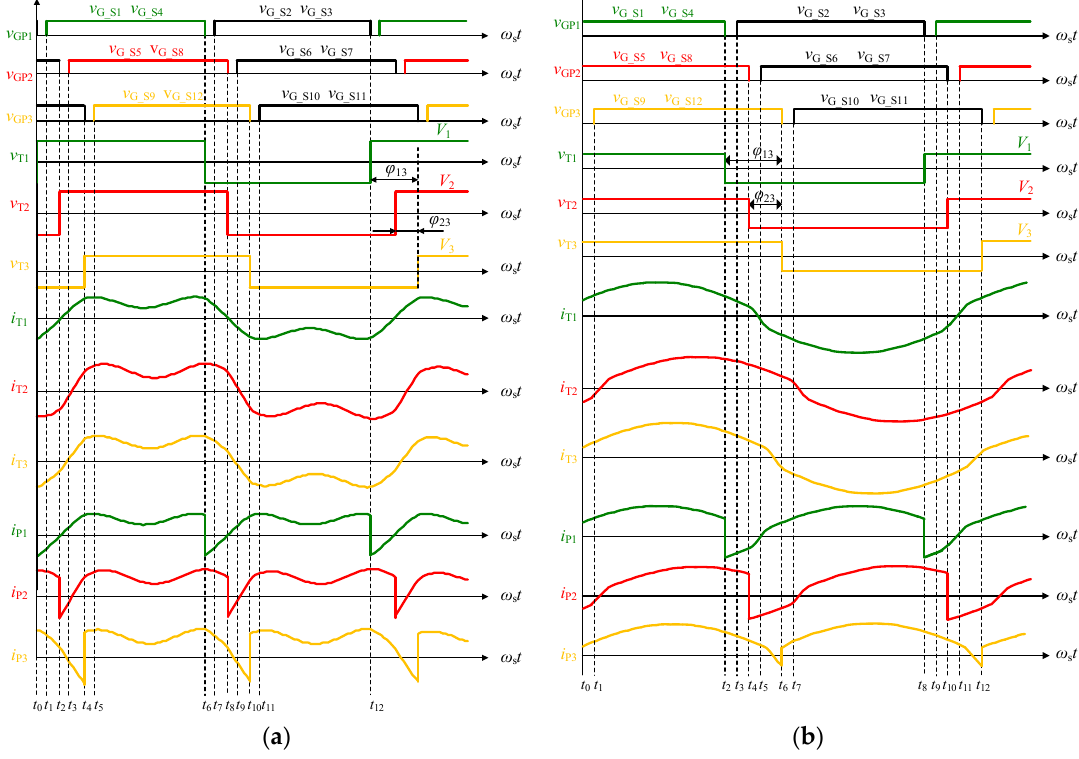
Figure 3. The current and voltage waveforms of MR-TBC and SR-TBC; ( a ) MR-TBC; ( b ) SR-TBC.